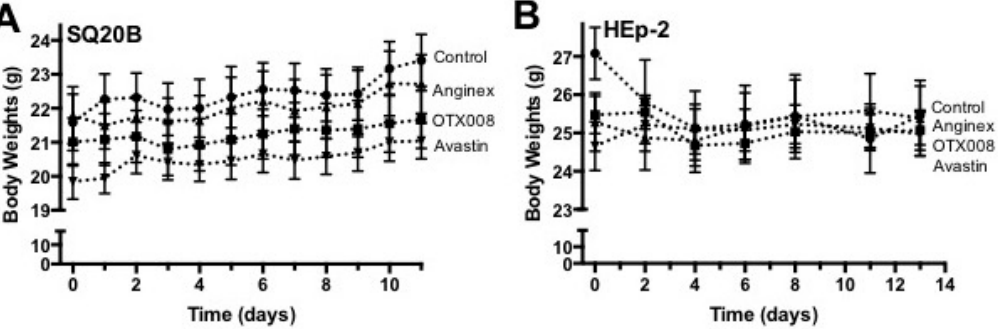
Figure 4. OTX008 does not show any sign of apparent toxicity. ( A ) In the SQ20B OTX008, Anginex and Avastin do not show any signs of apparent toxicity as measured by body weight fluctuation during treatment; ( B ) In the HEp-2 OTX008, Anginex and Avastin do not show any signs of apparent toxicity as measured by body weight fluctuation during treatment. Treatments: Control (vehicle; - -), Anginex (i.p. 10 mg/kg, q1d×21; n = 7; - -), OTX008 (i.p. 10 mg/kg, q1d×21; n = 7; - -), and Avastin (i.v. 10 mg/kg, q14d×2; n = 7; - -). Data points represent means ± SEM ( n = 7 each group).